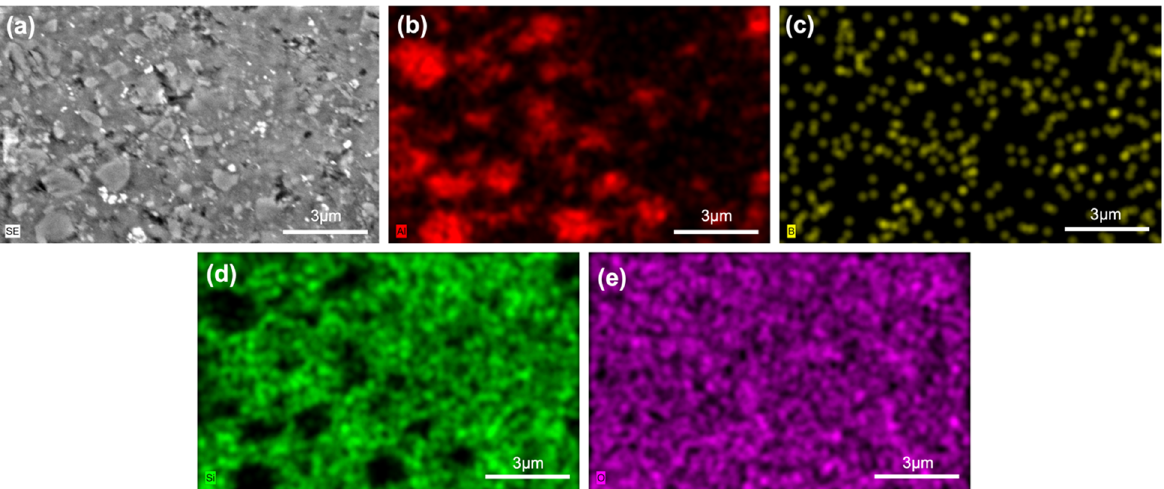
Figure 7. SEM/EDX analyses of the 30Al-O sample: ( a ) SEM image, ( b ) EDX mapping of Al, ( c ) EDX mapping of B, ( d ) EDX mapping of Si, and ( e ) EDX mapping of O.